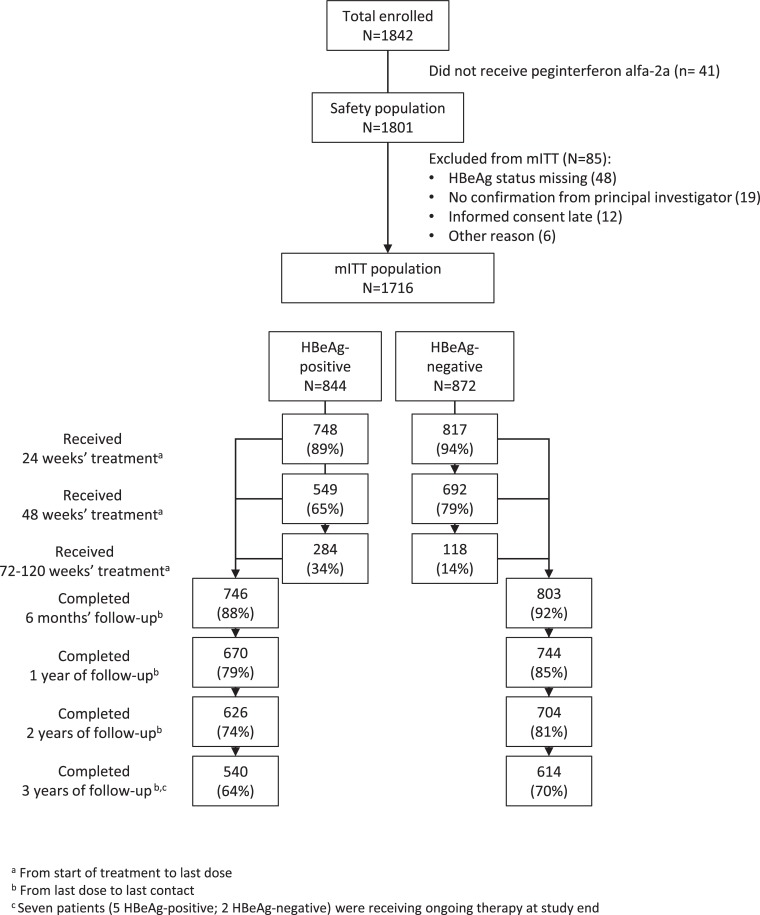
Patient disposition.HBeAg, hepatitis B e antigen; mITT, modified intention-to-treat. aFrom start of treatment to last dose. bFrom last dose to last contact. cSeven patients (five HBeAg-positive; two HBeAg-negative) were receiving ongoing therapy at study end.